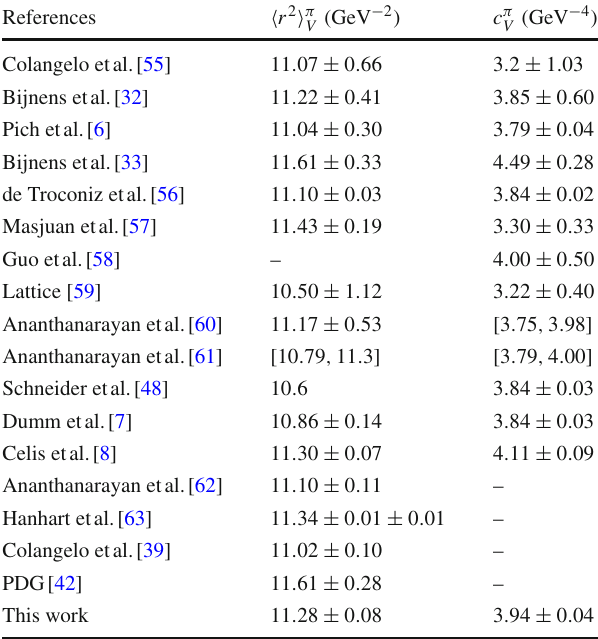
Table 5 Low-energy observables of the pion vector form factor up to the quadratic term. Statistical and systematic uncertainties have been added in quadrature. Some of the values of the charged pion radius (cid:5) r 2 (cid:6) π given in the table are not quoted in the original literature in units V of GeV − 2 but rather in fm 2 and the conversion has been evaluated by us